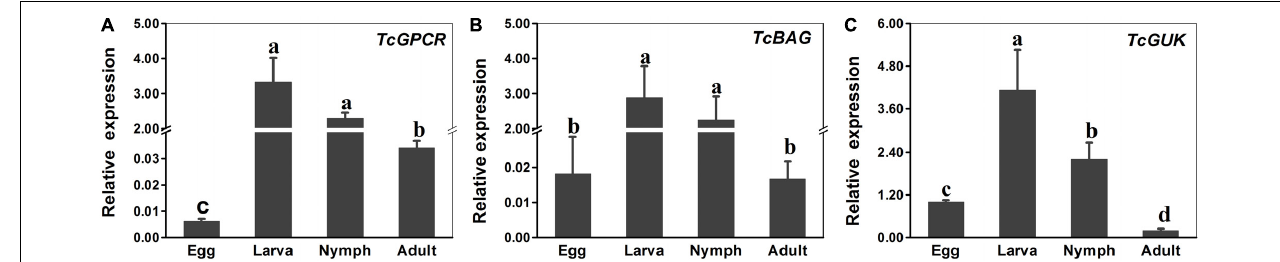
FIGURE 8 | RT-qPCR evaluation of the developmentally specific expression patterns of GPCR, BAG and GUK genes in T. cinnabarinus , respectively. (A) RT-qPCR analysis of TcGPCR expression in different life stages. (B) RT-qPCR analysis of TcBAG expression in different life stages. (C) RT-qPCR analysis of TcGUK expression in different life stages. The following life stages were analyzed: egg, larvae, nymph, and adult. Error bars represent the standard error of the calculated mean based on three biological replicates. Different letters on the error bars indicate significant difference according to Duncan’s multiple tests (alpha = 0.05). i.e., No statistical difference between “a” and “a”; significant difference among “a,” “b,” “c,” and “d.” RPS18 was used as the reference